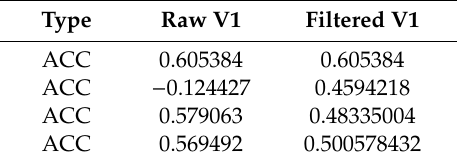
Table 2. Filtered values computed in acceleration values.